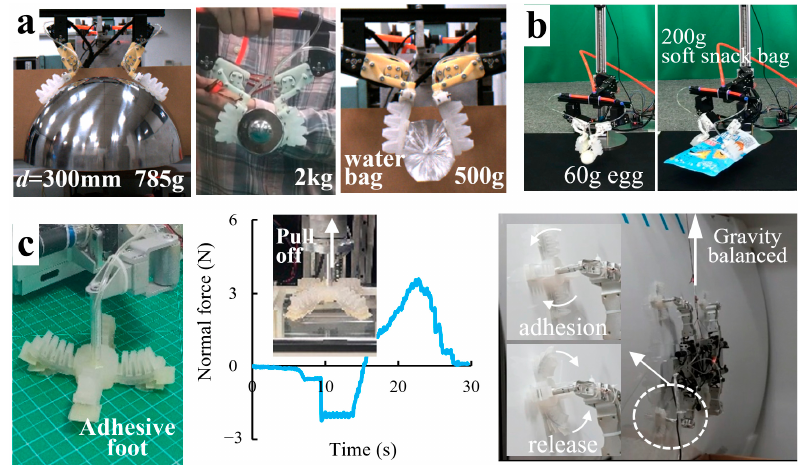
Figure 11. Application of the bio-toe in ( a ) a robotic adhesive gripper, ( b ) an automatic adhesive gripping system, and ( c ) a wall-climbing robot.